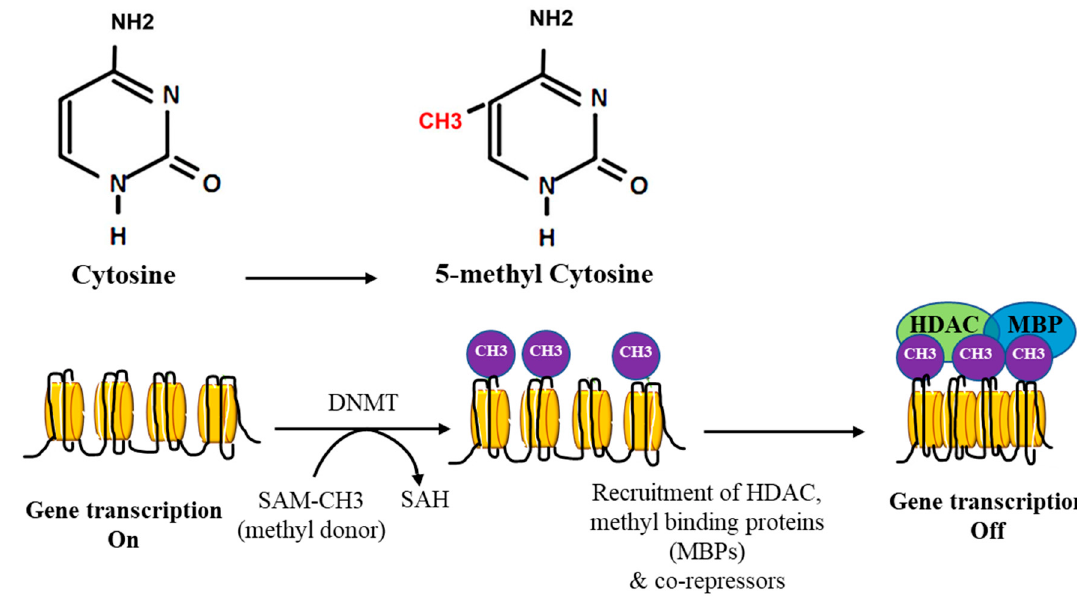
Figure 2. Schematic representation of DNA methylation and its effect on gene transcription. DNA methyltransferase (DNMT) converts cytosine to 5 ′ methyl-cytosine. The process involves the transfer of a methyl group from S-adenosylmethionine (SAM) to the cytosine resulting in the conversion of DNA to methylated DNA and methylated SAM to non-methylated S-adenosylhomocysteine (SAH). DNA methylation recruits histone deacetylase (HDAC), methyl binding proteins (MBPs), and other transcription repressing factors. These modifications result in closed chromatin conformation, inaccessibility to transcriptional machinery, and eventually gene silencing.